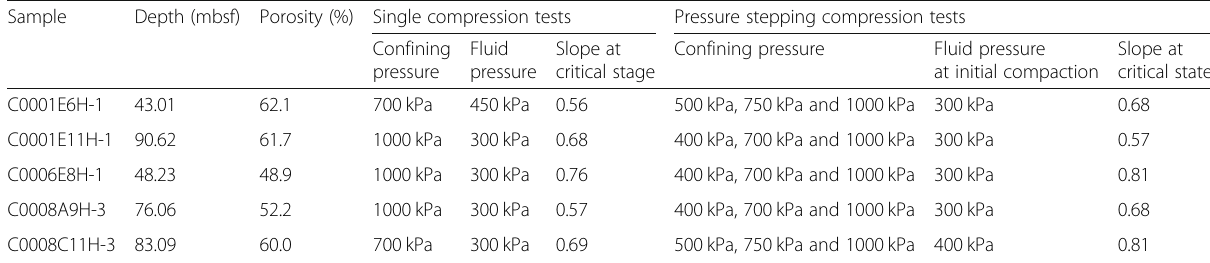
Table 1 Sample list, settings of laboratory tests, and internal friction results. Data of core samples C0001E11H-1, C0006E8H-1, and C0008A9H-3 are taken from Stipp et al. (2013) Sample